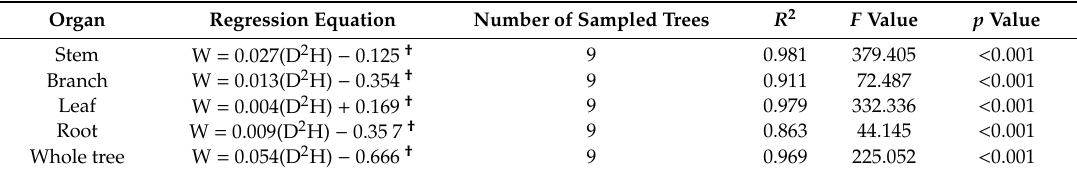
Table 2. Biomass allometric equations of Quercus gri ffi thii